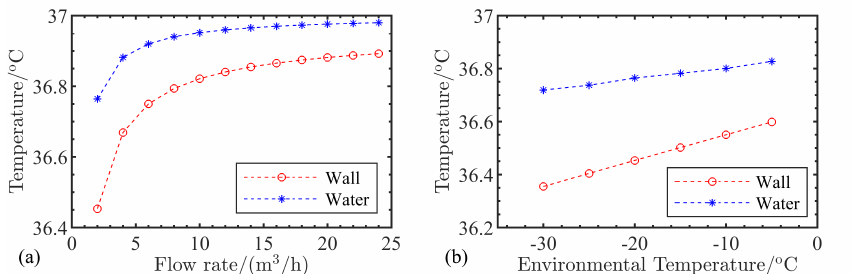
Figure 4. Plots of the temperature of the water and the surface of the wall at the outlet of the heat exchanger. The independent variables in ( a , b ) are flow rate and environment temperature, respectively.